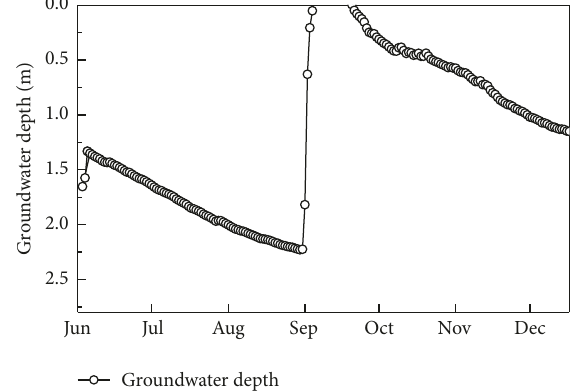
Figure 5: The variation of groundwater depth